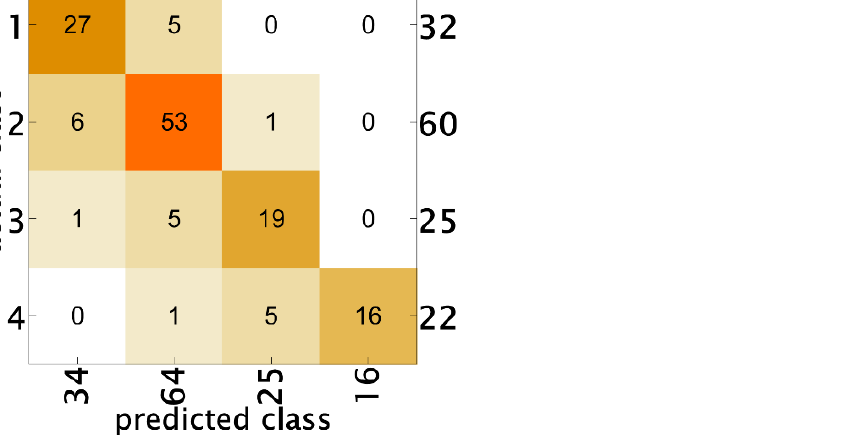
Figure 3. Decision matrix of logistic regression: 1 — brefomatrix from spongy bone, 2 — brefomatrix from cortical bone, 3 — biomaterials from dentin of juvenile teeth with demineralization in 1.2 Н, 4 — biomaterials from dentin of juvenile teeth with demineralization in 1.8 Н .